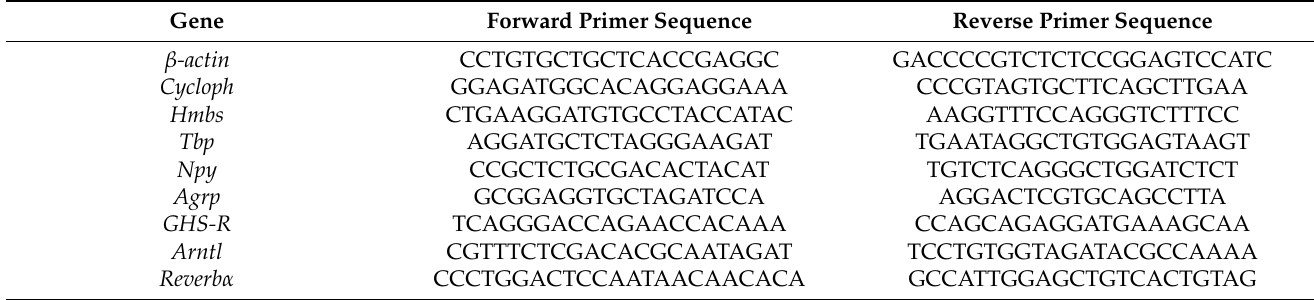
Table 1. Primers used for